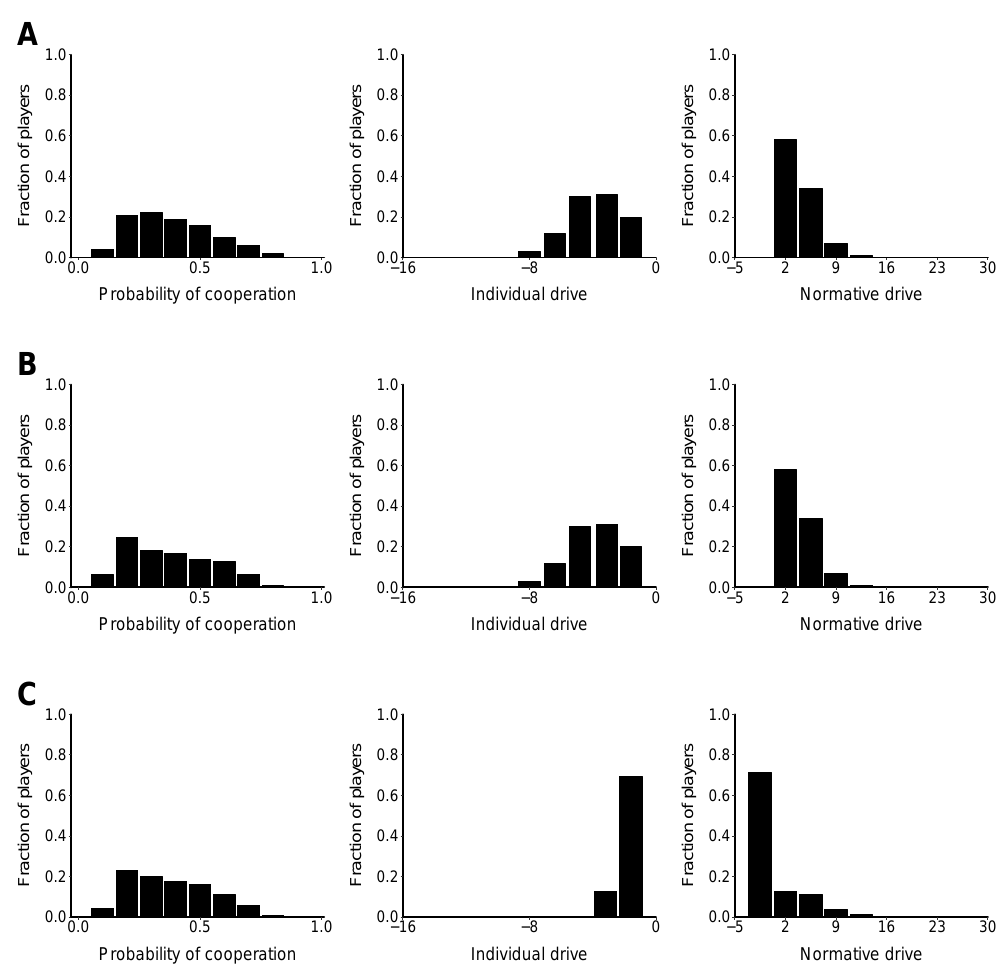
Figure 2. Stationary state. Fraction of agents who reached a given probability of cooperation (left column), a certain individual drive (middle column), and a given normative drive (right column) for the: ( A ) dynamic lattice treatment; ( B ) static lattice treatment; and ( C ) regular random network